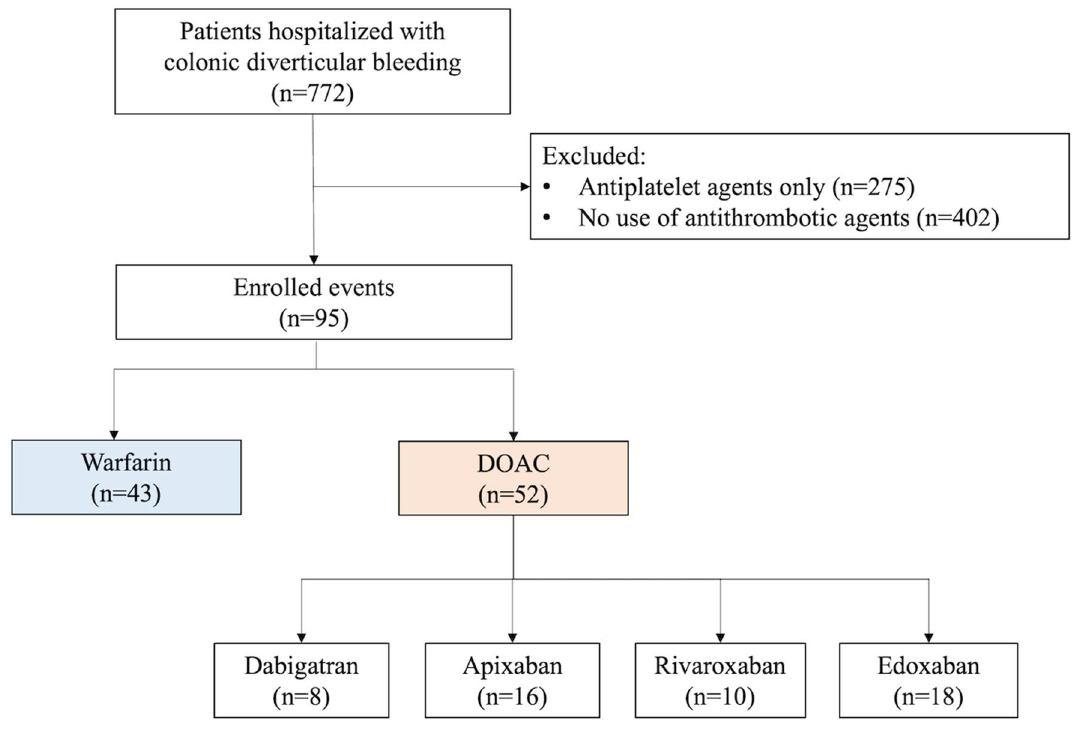
Figure 1. Flowchart of patient selection.